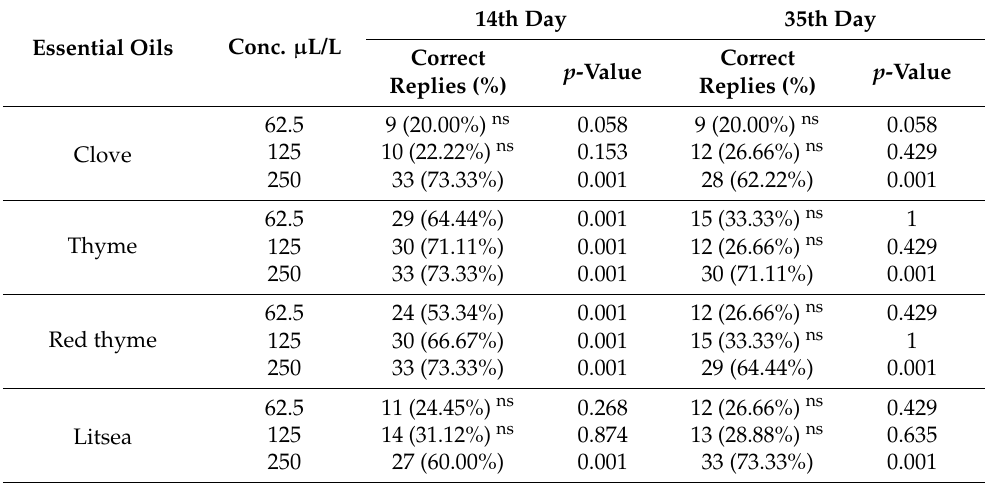
Table 7. Sensory evaluation of the cheese samples treated by the most effective essential oils on 14th and 35th day after storage at 5 ± 1 ◦ C in